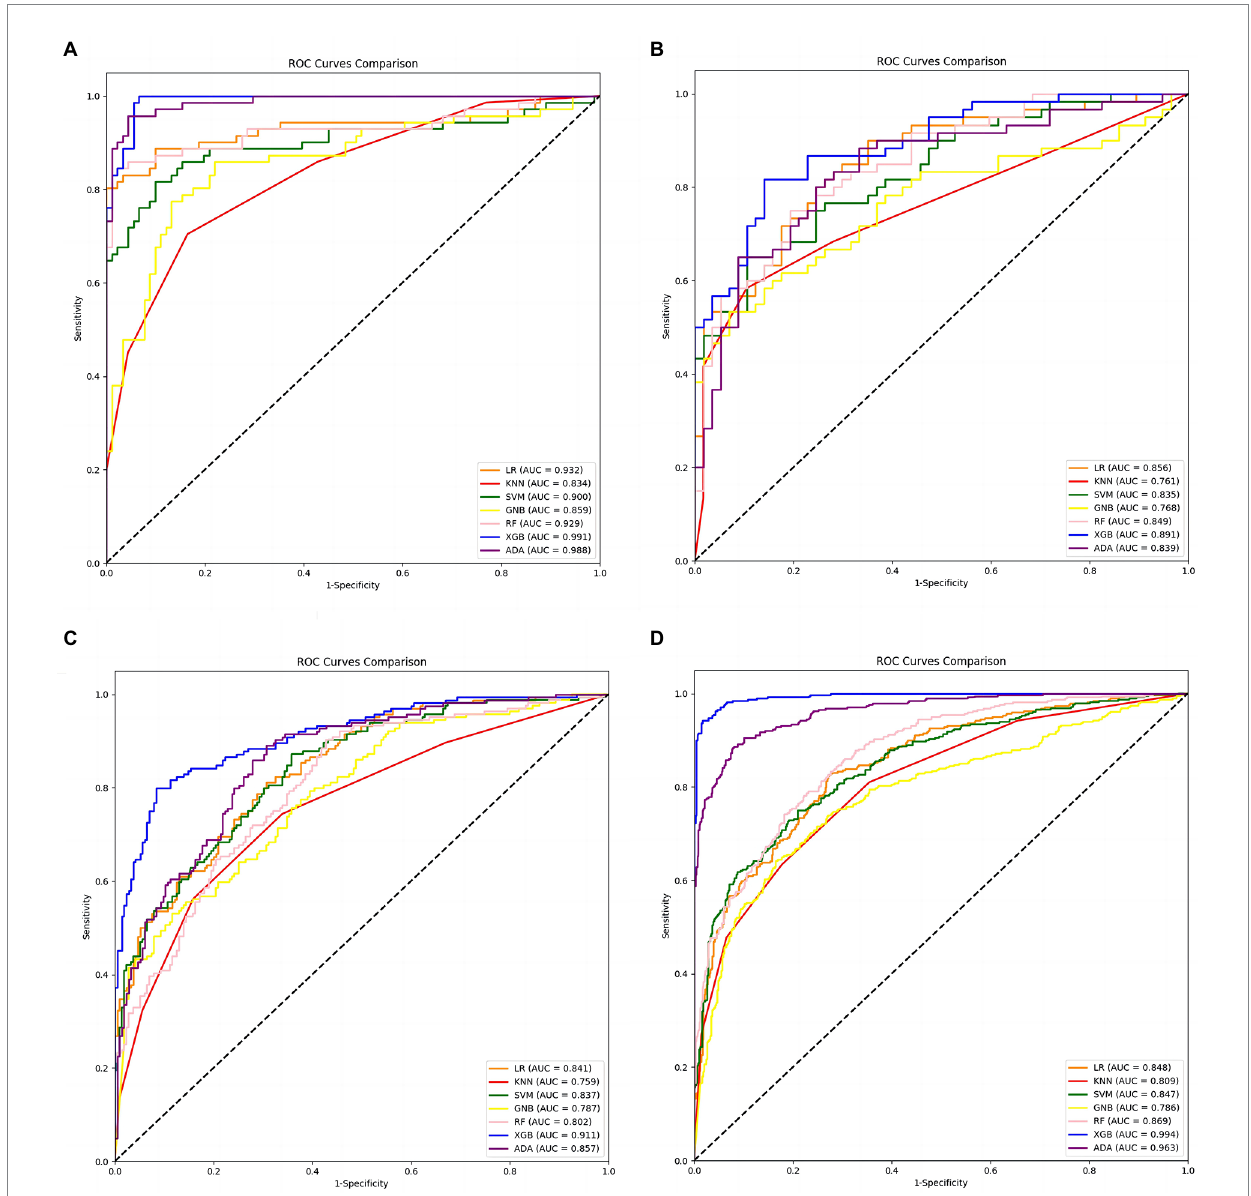
FIGURE 4 Receiver operating characteristic (ROC) curves were calculated to differentiate AD patients and healthy controls. (A) ROC curves for each classifier in Task 1. (B) ROC curves for each classifier in Task 2. (C) ROC curves for each classifier in Task 3. (D) ROC curves for each classifier in Task 4. The black dashed line indicates the performance of the random